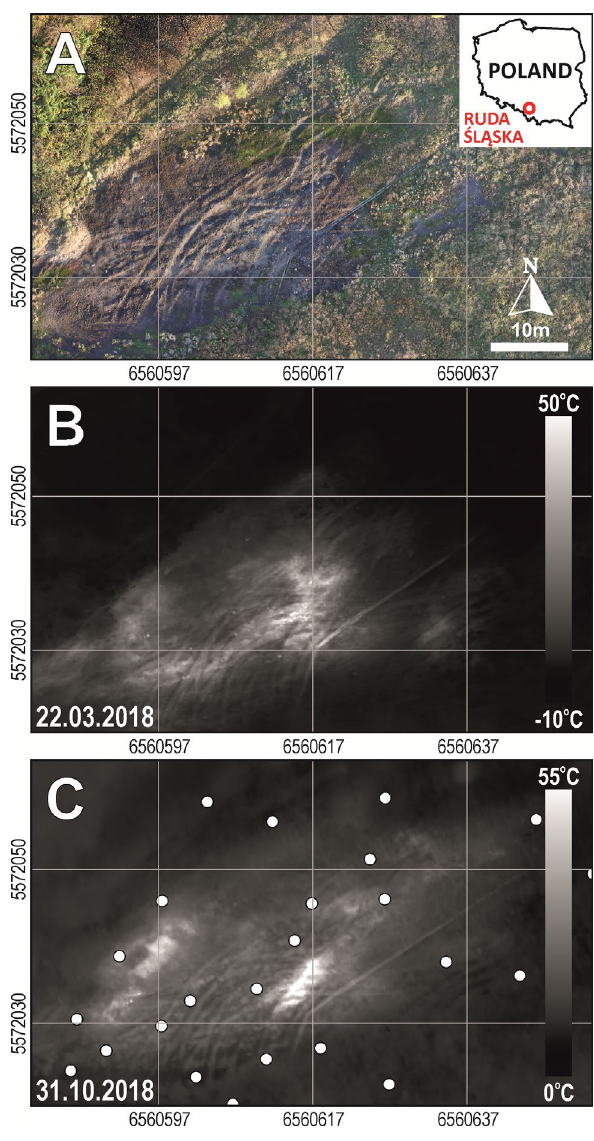
Figure 1. Fire spot on the coal- waste dump in Ruda Śląska : A – orthophotomap; B - thermal map: 22.03.2018; C - thermal map: 31.10.2018 (points - see Figure 3); coordinate system Poland CS2000 zone 6, EPSG: 2177 (5572050, 6560597 = WGS 8 4: 50°16ʹ52.57ʺN, 18°51ʹ0.86ʺE ) A fire spot registered from the air is also noticeable in thermal photos taken from the ground by the handheld IR camera (Figure 2). Due to the diversity of the ground (it is not perfectly flat), its coverage and the variability of the angle of taking pictures, the fire border is not as well outlined as in the pictures from the drone. These photos may also be subject to an additional error because they were taken during sunrise (at the beginning of the sky brightening), which may cause the influence of the cold sky reflection (Nowak, 2013).